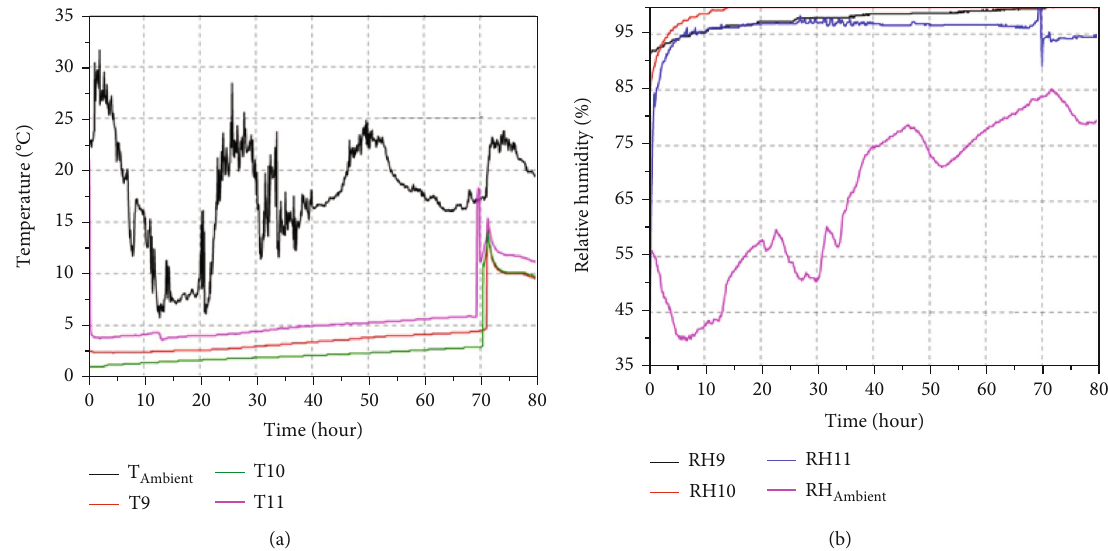
Figure 6: Time evolution of the temperature and RH inside the carrying items under dynamic